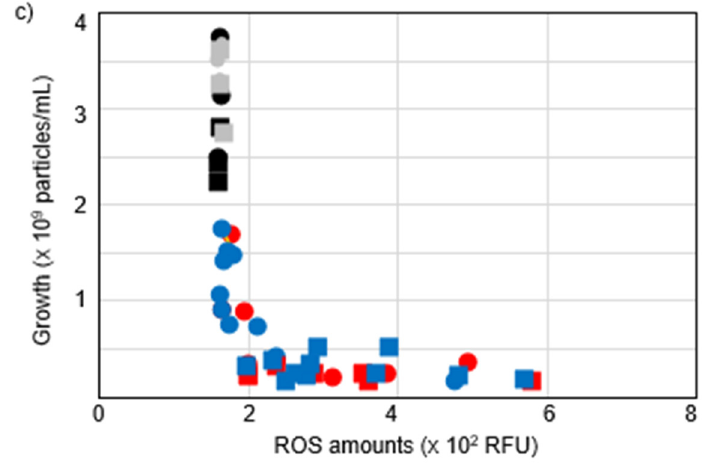
Figure 6. Scatterplots of how vitamin C affects mean ROS levels and cell growth in recAts polA cells and recAts polA ∆ hslO cells in permissive and restrictive conditions. ( a ) Effect of vitamin C on a scatterplot with mean ROS levels and cell growth in recAts polA cells (TK3077) in permissive and restrictive conditions. In the early logarithmic growth phase (O.D. 600 = 0.1), the TK3077 ( recAts polA ) culture was observed. The measurements were plotted for ROS levels and optical growth on the x- and y-axis, respectively. Round symbols indicate measurements on cells without vitamin C ( − C) or with 100 µ M vitamin C (+100 µ M C). ( b ) Vitamin C effect on a scatterplot for mean ROS levels and cell growth in recAts polA ∆ hslO (TK3276) cells in permissive and restrictive conditions. In the early logarithmic growth phase (O.D. 600 = 0.1), the TK3276 ( recAts polA ∆ hslO ) culture was examined. The results are represented just as in ( a ) using square symbols. ( c ) Vitamin C effect on a scatterplot with mean ROS levels and cell concentrations in permissive and restrictive conditions. This replot shows ROS levels and cell concentrations on the x- and y -axis, respectively. Measurement points are indicated as in ( a , b